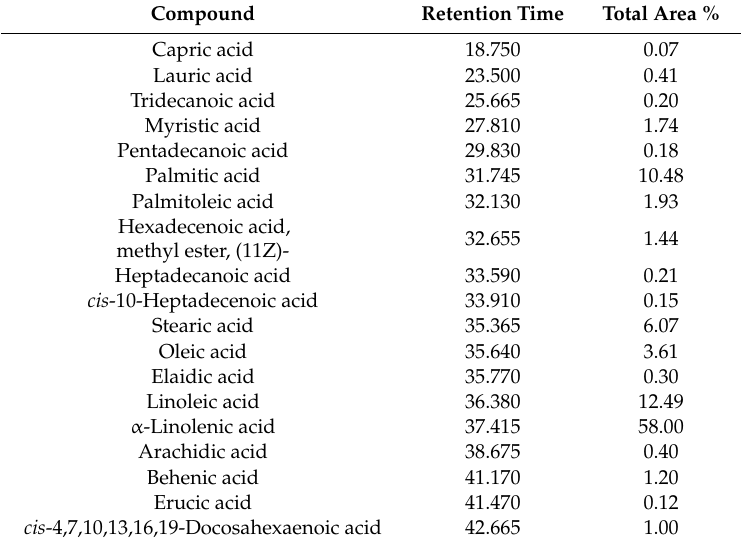
Table 4. Profile of fatty acids in S. crispus